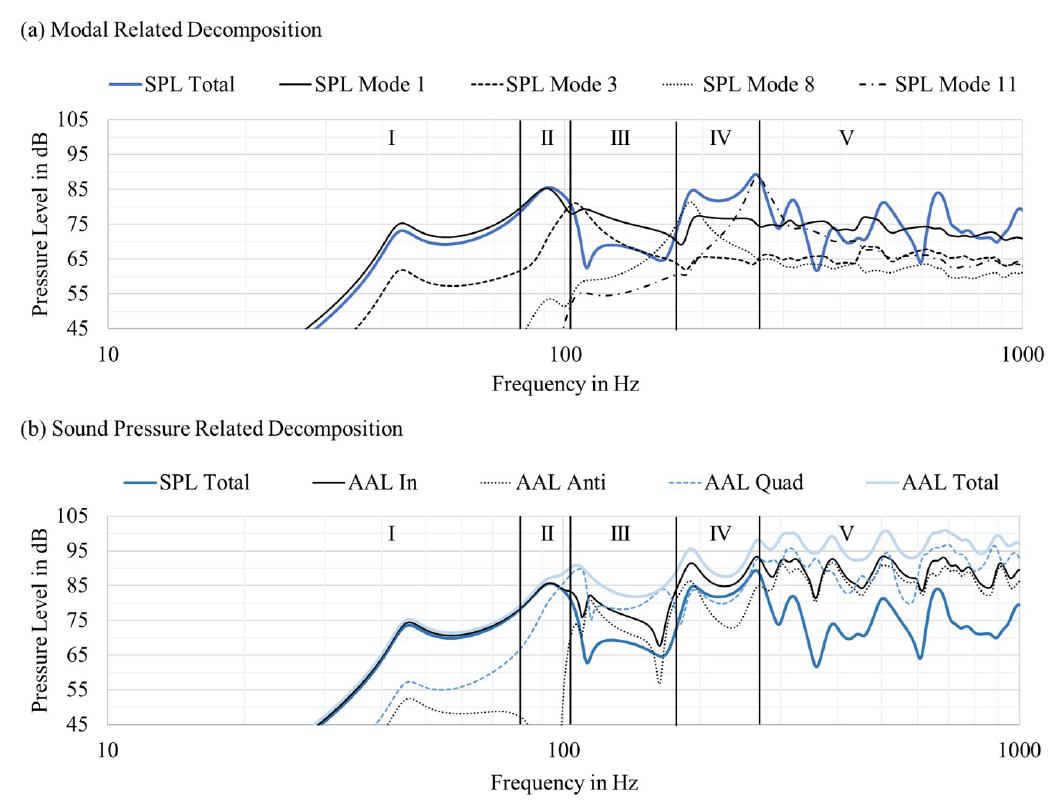
Figure 7. Simulated modal related and sound pressure related decomposition of the panel with an exciter (standard construction). The contribution of Modes 1–11 is extracted. All symmetrical eigenmodes are not excited due to the centered exciter